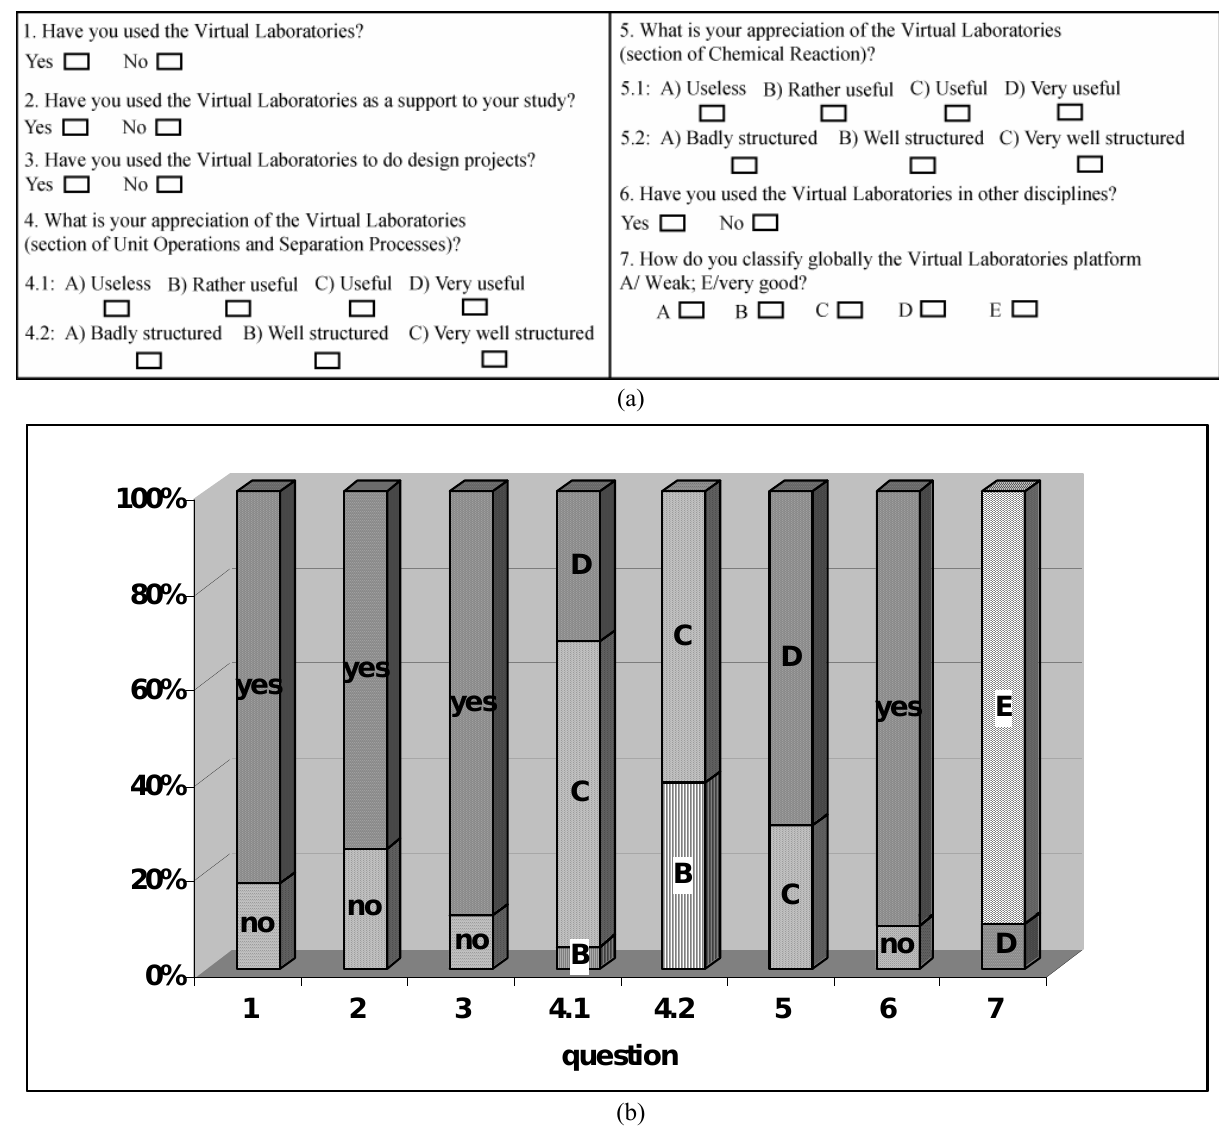
Figure 2. Assessment of the platform: (a) questionnaire; (b) results.